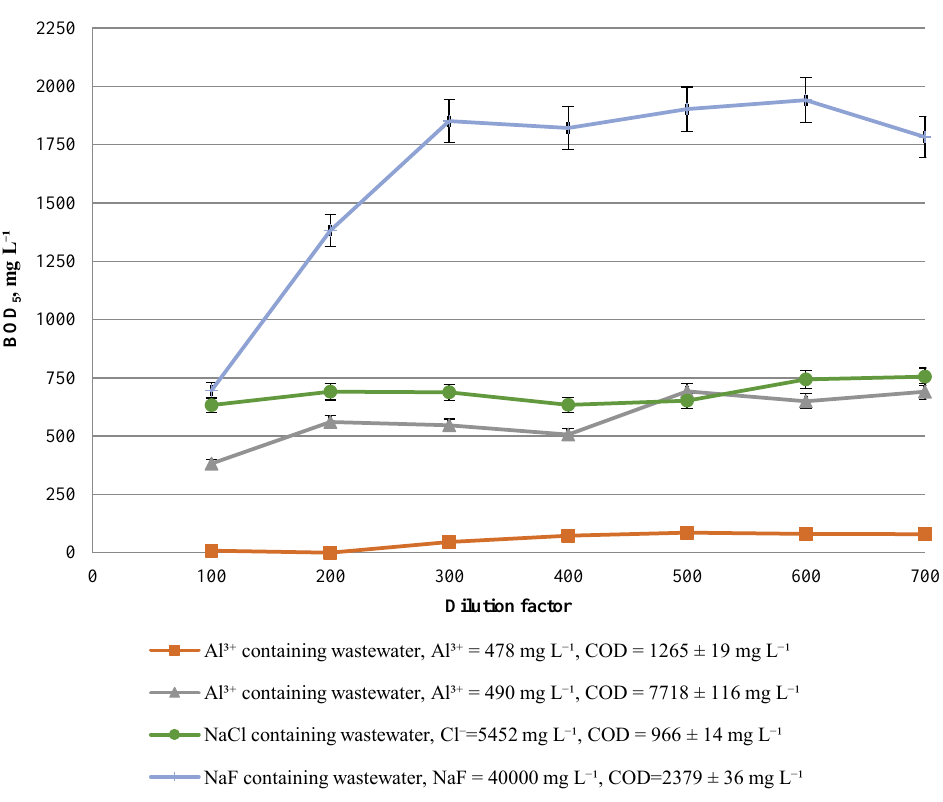
Fig. 2. BOD 5 values of pharmaceutical wastewater's streams containing inorganic salts depending on dilution factor. The salinity inhibition on biological treatment is mainly caused by osmotic pressure, which may lead to plasmolysis of microbial cells and eventual death of microorganisms eventually leading to the failure of biological treatment systems [36], [37]. Major fluctuation of salinity can cause salinity shock, for this reason, high salinity wastewater must be diluted before biological treatment in most cases, which increases operational costs and water consumption [36]. Each microbial species has its optimum growth salinity, and microorganisms will lose their activity beyond the tolerance limit [38]. In many studies halophilic salt-tolerant microorganisms were considered adaptable to treat saline wastewater [34], [37]. Salt-adapted microorganisms are capable of withstanding high salinities and at the same time of degrading the pollutants that are contained in wastewater [35]. As salt removal from saline wastewater by reverse osmosis or ion exchange is expensive, biological treatment of hyper-saline wastewater with halophilic sludge is recommended